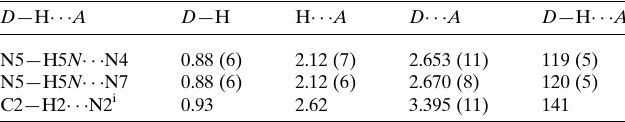
Table 1 Hydrogen-bond geometry (A˚ , (cid:3)